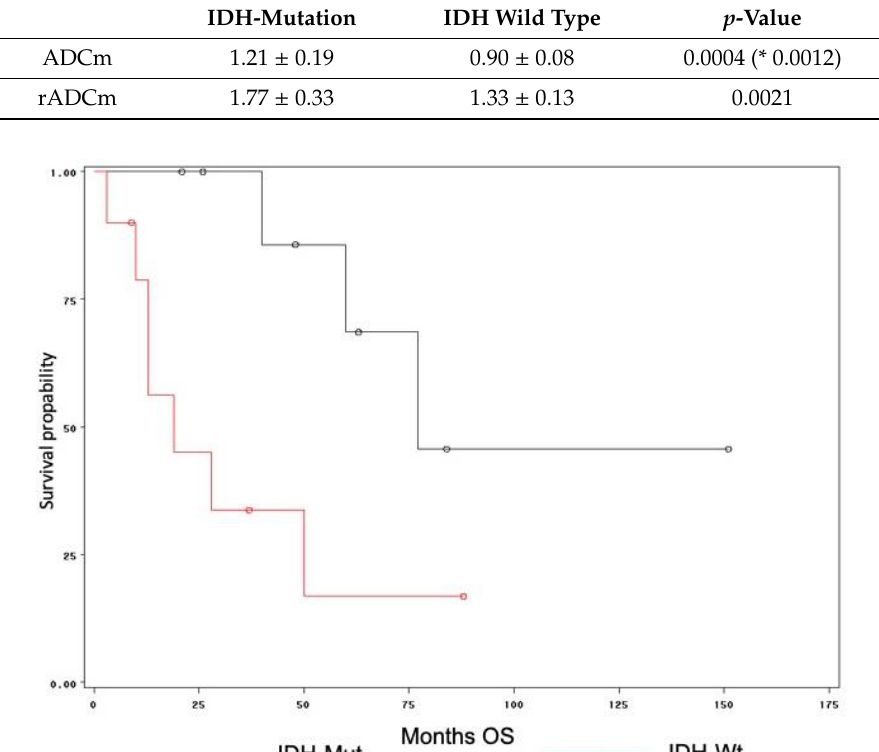
Figure 5. Kaplan-Meier curve with log-rank tests were used to examine differences in the overall survival (OS) among the different molecular subgroups. The red line represents the IDH-Wt tumors ( n = 11), and the black line represents the IDH-Mut tumors ( n = 9). The median OS in the IDH-Wt subgroup was significantly shorter (16 months) than the OS in the IDH-Mt (60 months; p < 0.001) subgroup.